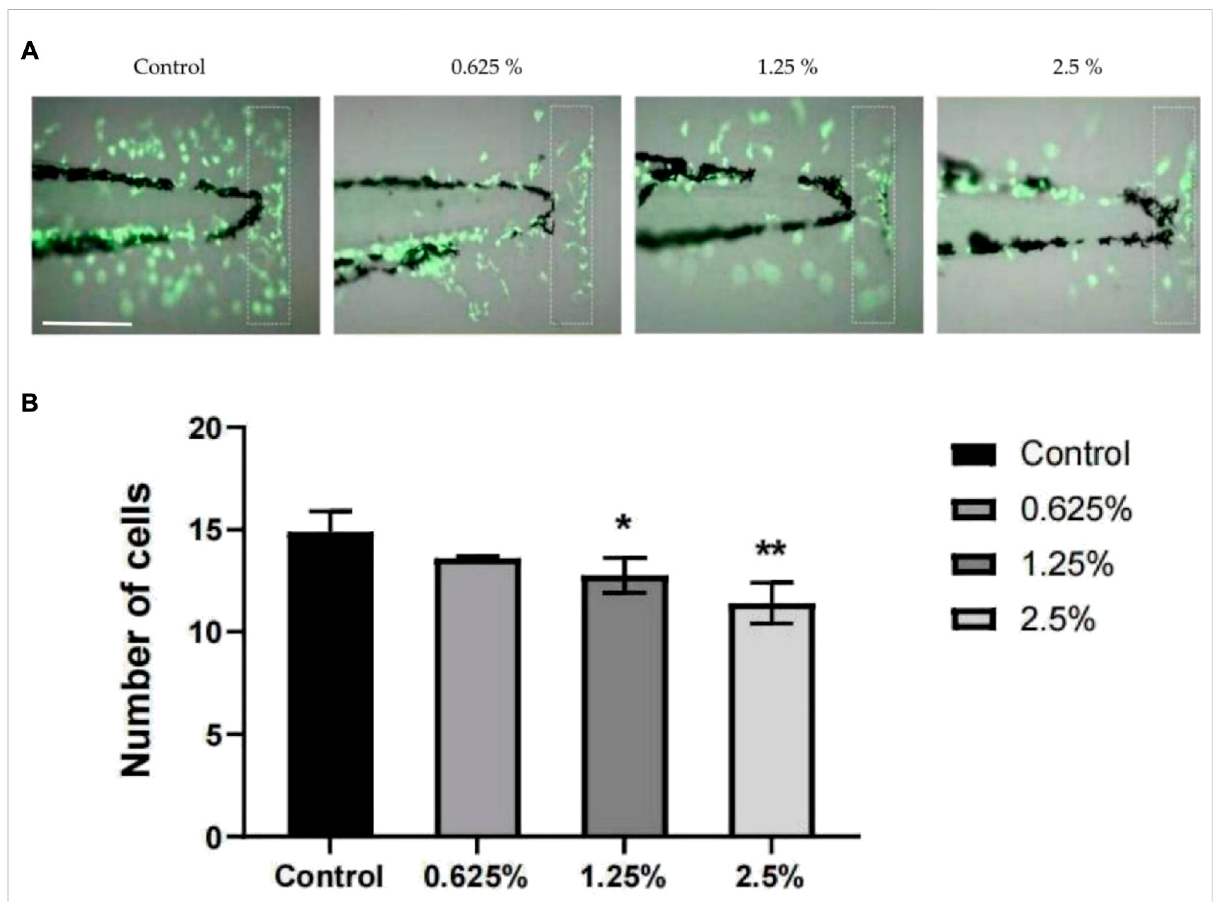
Anti-in fl ammatory effect of vine tea fermented broth, the scale in the fi gure is 200 μ m. (A) Distribution of in fl ammatory cells in the tail of zebra fi sh larvae induced by tail cutting. (B) Number of cells recruited in the caudal (* p < 0.05, ** p < 0.01 vs. Control